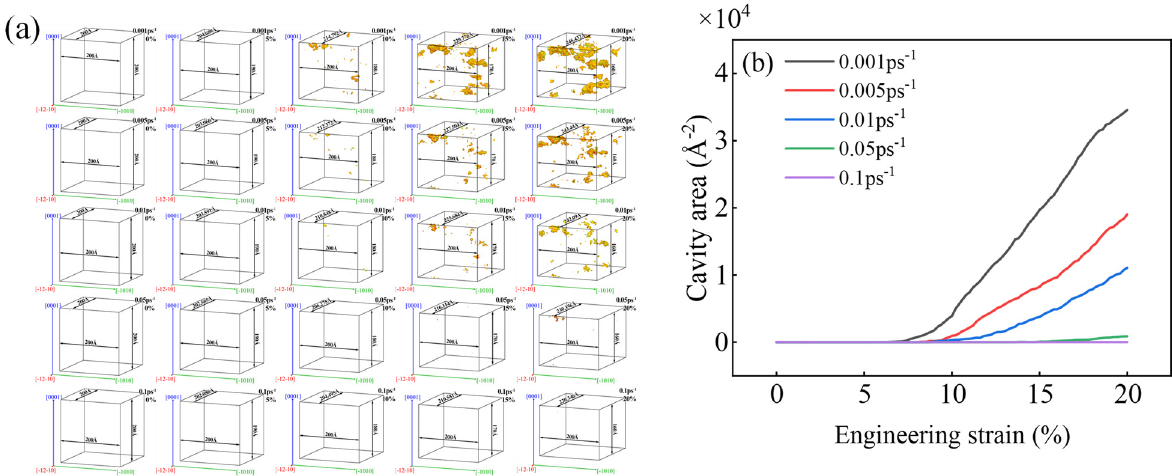
Figure 19: Cavity evolution: ( a ) cavity diagram and ( b ) cavity